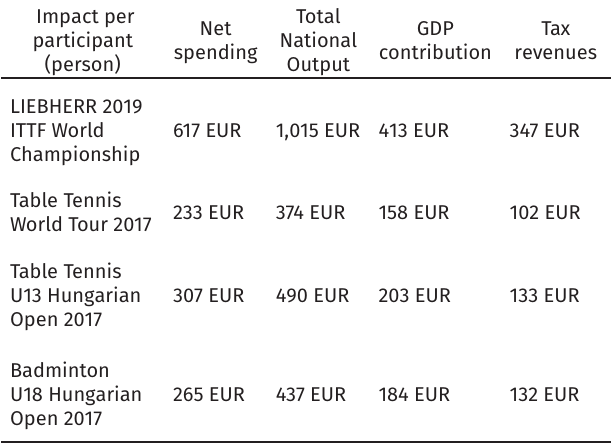
Table 3. Economic impact per participant of international sports events in